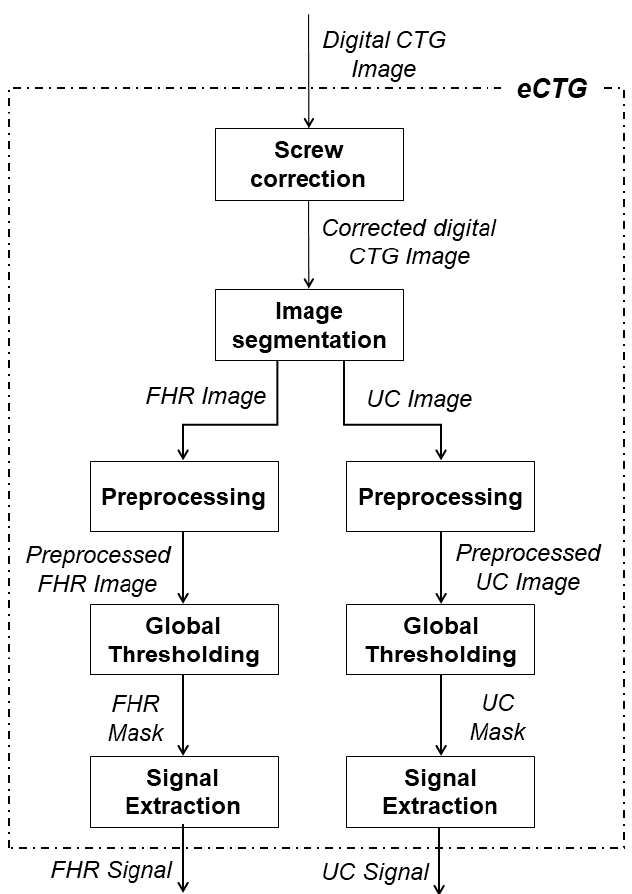
Figure 2. Block diagram of eCTG algorithm used to extract digital fetal heart rate (FHR) and uterine contraction (UC) signals from digital CTG images.